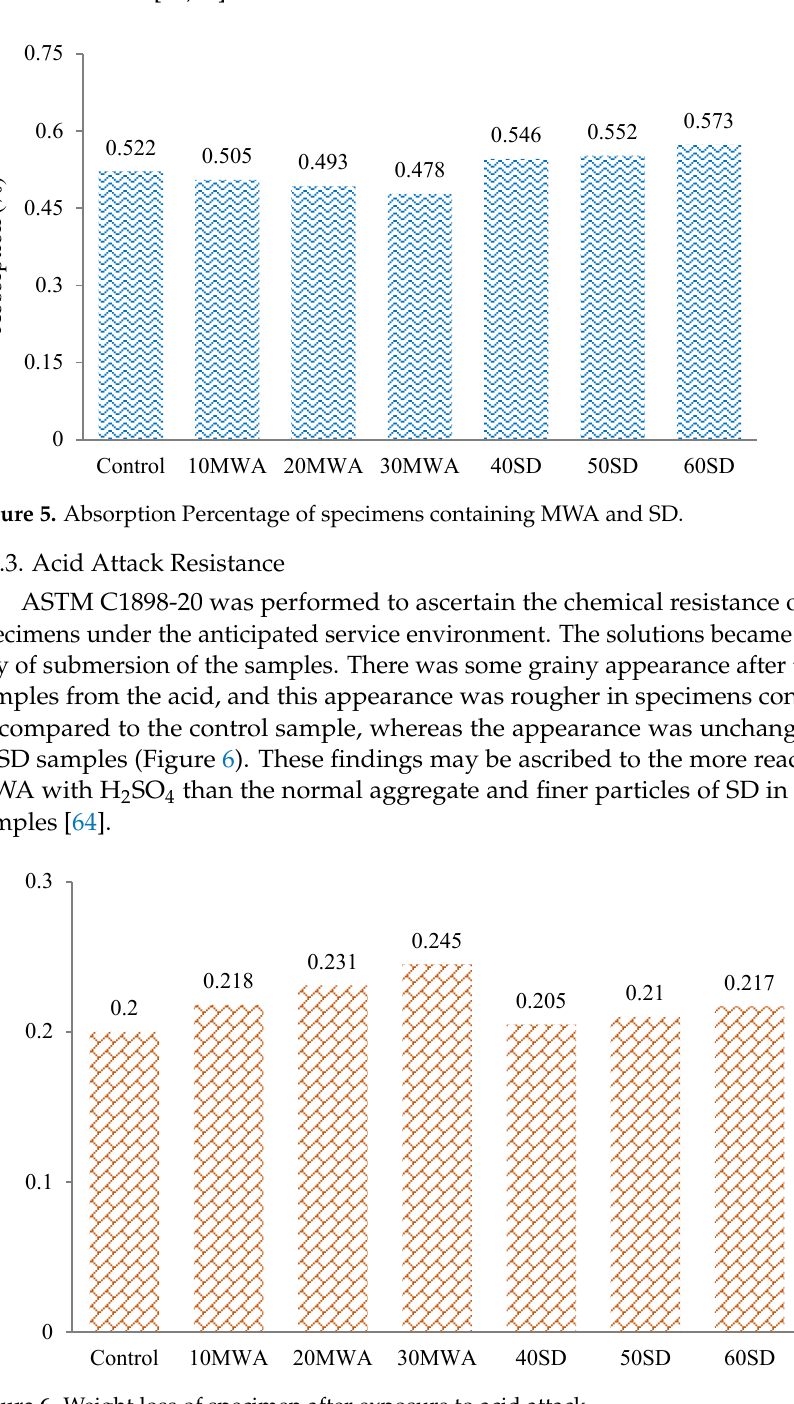
Figure 4. Compaction Factor Test .